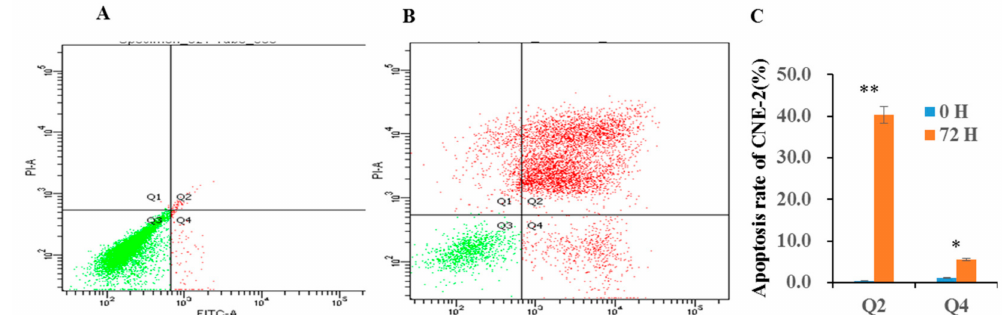
Figure 3. Compound 1 can promote CNE-2 cell apoptosis. Cells were labeled with Annexin-Fluorescein isothiocyanate (FITC) and Propidium Iodide (PI), and analyzed by flow cytometry (FCM): ( A ) untreated; ( B ) treated with 6.34 µ M for 72 h; ( C ) Effects of compound 1 on apoptosis in CNE-2 cell. Q2 and Q4 stand for late stage and early stage, respectively. * p < 0.05, ** p < 0.01 compared with the control group. Data are expressed as the mean ± standard deviation (SD). n =